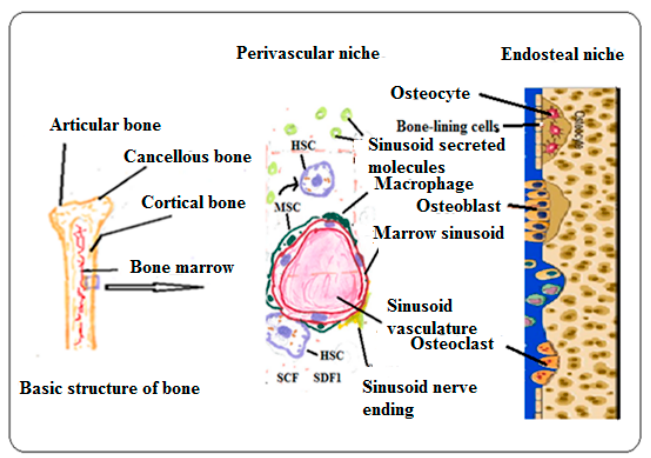
Figure 3. Schematic of structural composition of BM and the cellular interactions.